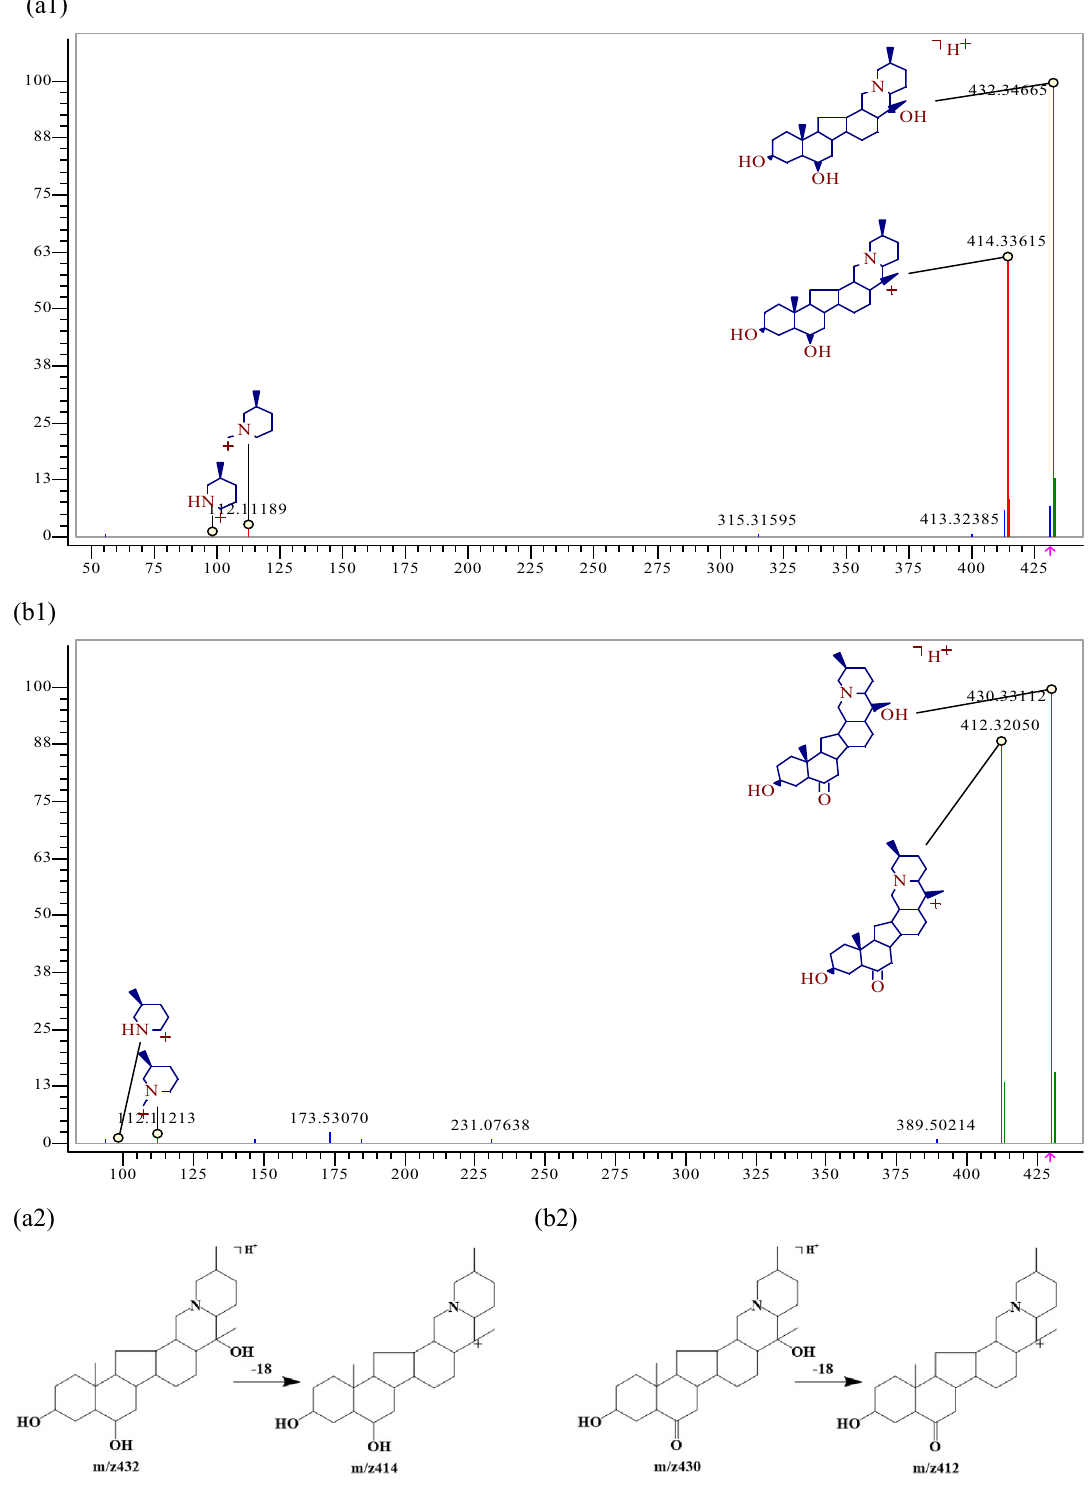
Figure 5. MS 2 spectra and the cracking diagram of ( a ) Peimine, ( b )